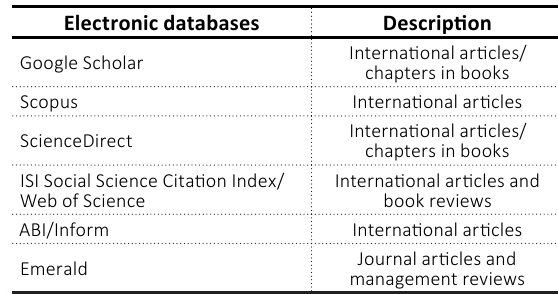
Table 1. Electronic databases used